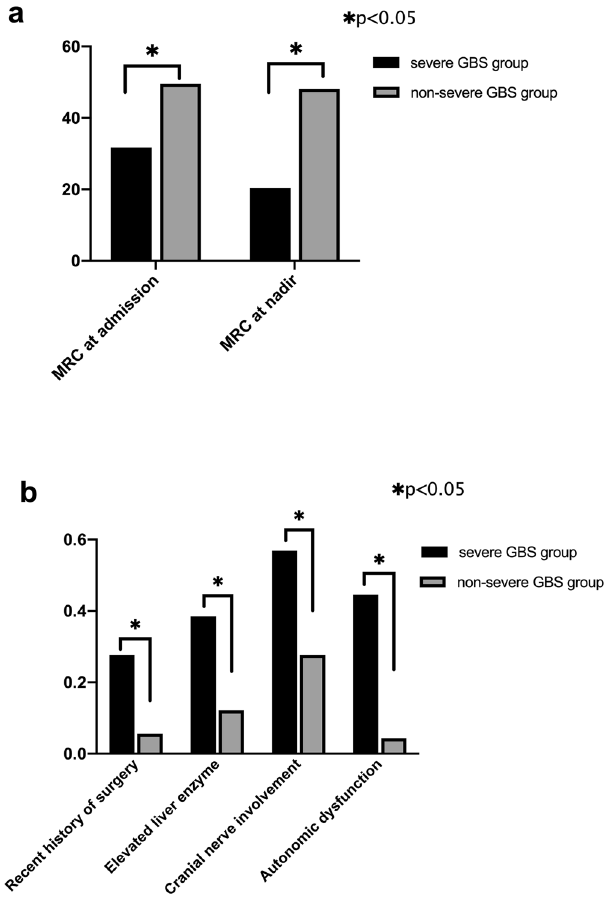
Figure 1. Comparisons between severe GBS group and non-severe GBS group. ( a ) MRC at admission and MRC at nadir in severe GBS group were both lower than non-severe GBS group (both p < 0.05). ( b ) In severe GBS group, recent history of surgery, elevated liver enzyme, cranial nerve involvement and autonomic dysfunction were totally higher than non-severe GBS group( p < 0.05).